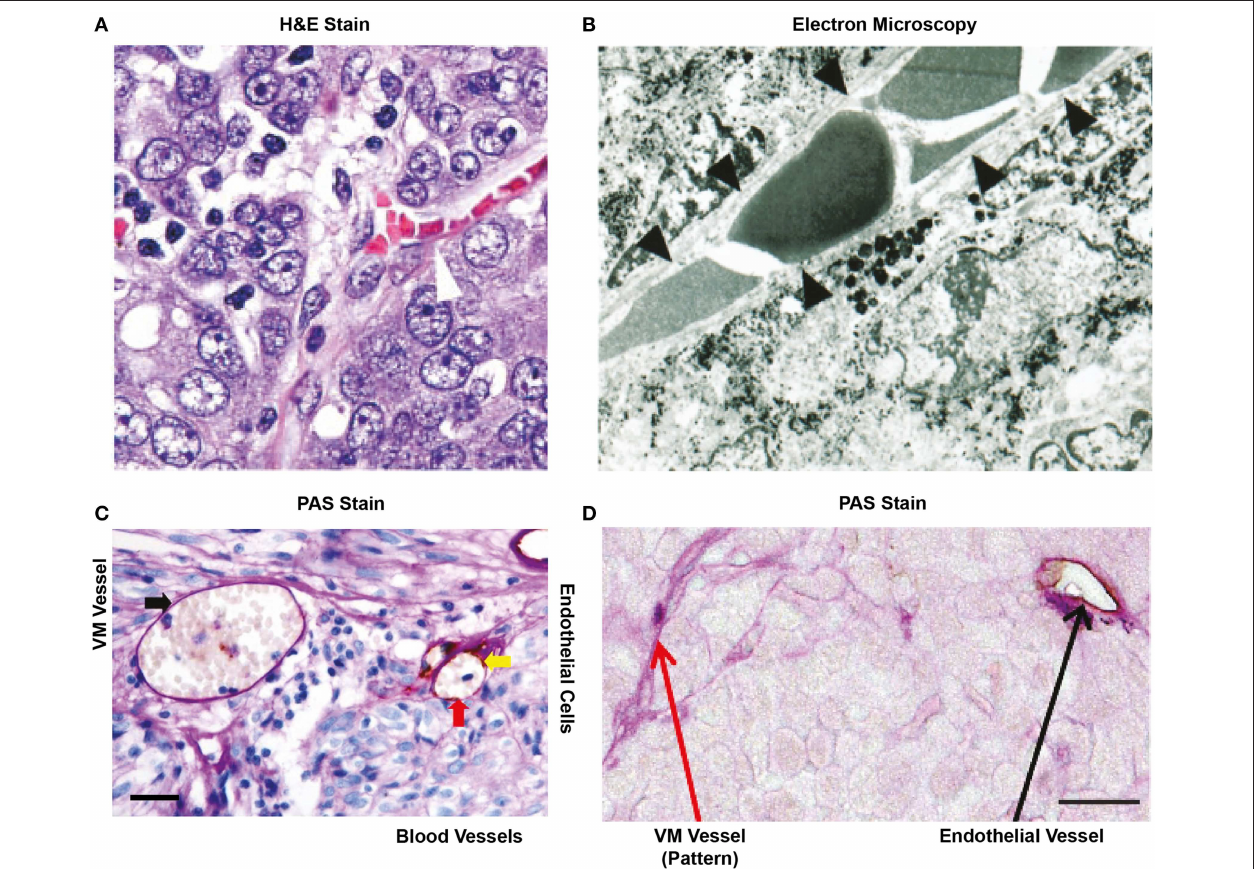
FIGURE 2 | Historical representation of in vivo VM from the literature. (A) H&E stain of an ovarian tumor showing that red blood cells are contained in a structure lined by cancer cells (arrow head), not endothelial cells. Image taken with kind permission from the publication by Sood et al. (12). (B) Electron microscopy of a uveal melanoma showing that red blood cells are contained within a structure lined by cancer cells (as confirmed by the presence of melanin in these cells). Taken with kind permission from the publication by Maniotis et al. ( 13). (C) Cross section of a glioblastoma after staining for PAS and CD31. The red arrow indicates an endothelial lined blood vessel with PAS + luminal stain and positive for the endothelial marker CD31 (yellow arrow). RBCs (red arrow) are shown within the structure. In the same cross-section, a PAS + yet, and CD31 negative structure is also present that contains red blood cells (black arrow). This may represent VM. Size bar represents 100 µ m. Taken with kind permission from the publication by Sun et al. (14). (D) Small lung cell carcinoma cross section showing the presence of a PAS + /CD31 + blood vessel (black arrow) and the presence of PAS + “patterned structures” that have been speculated to represent VM (red arrow). Size bar represents 100 µ